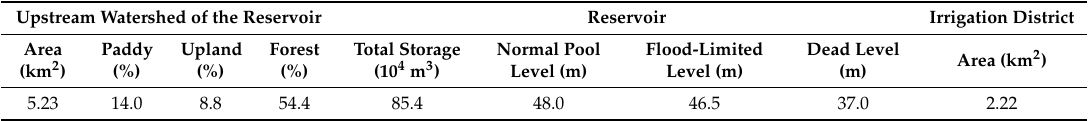
Table 2. Basic data for the Seon-Am Reservoir, the upstream watershed, and the irrigation district used in this